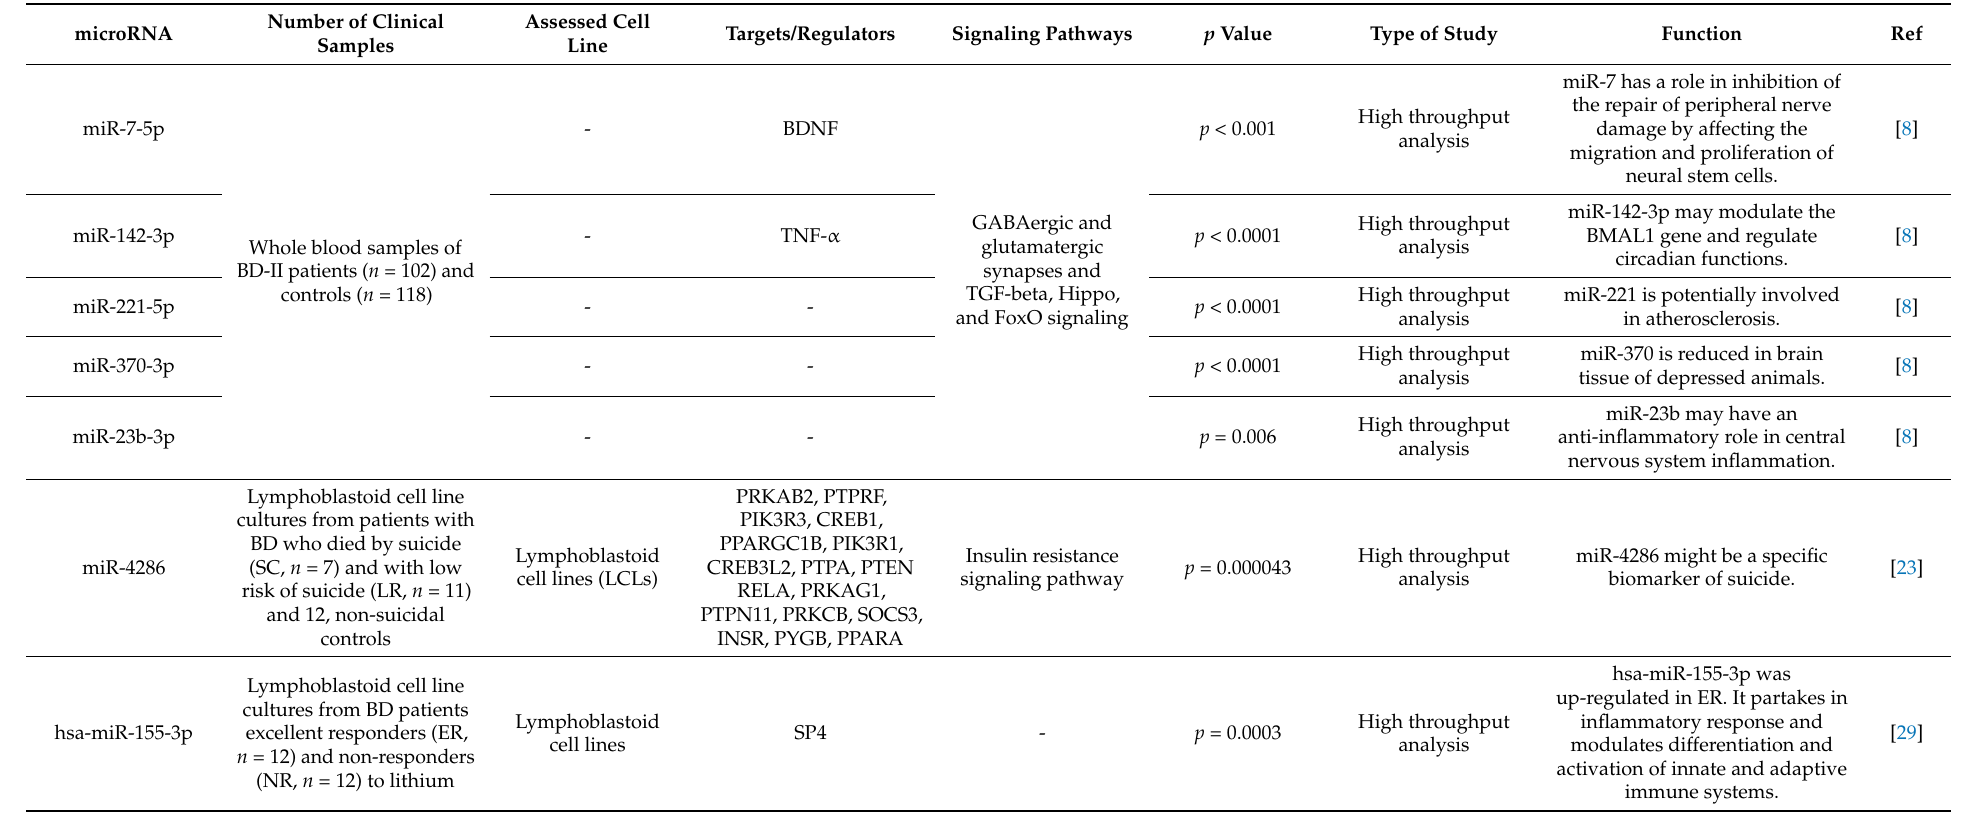
Table 5. Summary of function of up-regulated miRNAs in BD (BD: bipolar disorder, SZ: